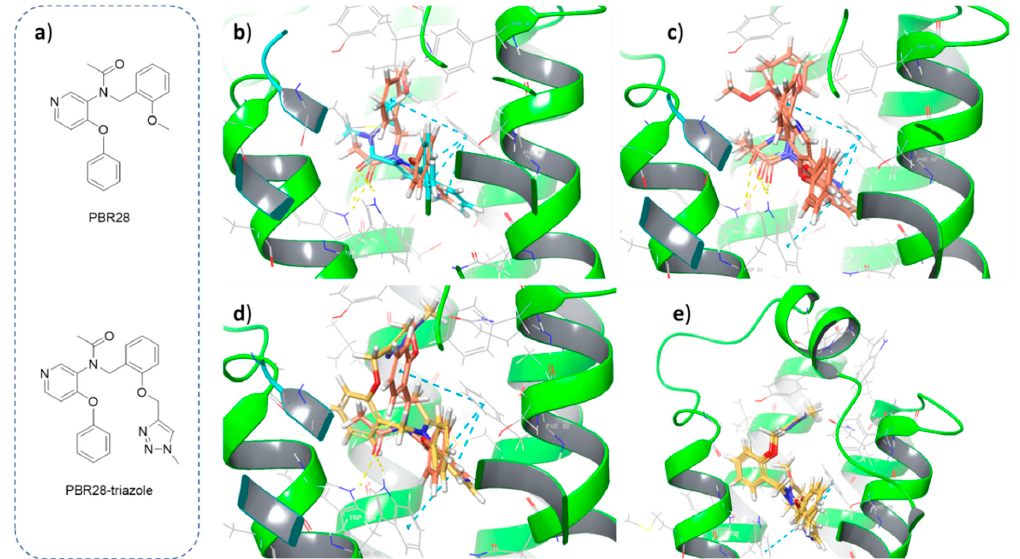
Figure 2. Chemical structures and docking poses of PBR28 and its derivative PBR28-triazole. Three-dimensional structures of ligands and key residues are shown as sticks. Hydrogen atoms are reported in white, oxygen in red and nitrogen in blue. H-bonds are depicted as yellow dotted lines, π – π stacking interactions are reported as blue dotted lines. ( a ) Two-dimensional structures of docked compounds, ( b ) superimposition of docked PBR28 (orange) with co-crystallized PK11195 (cyan), ( c ) superimposition of the best docking poses for PBR28, ( d ) superimposition of docked PBR28-triazole (yellow) with PBR28 (orange), ( e ) view of the best docking poses of PBR28-triazole. Table 1. Glide docking scores were obtained with Maestro for the top four poses of each ligand docked on TSPO.